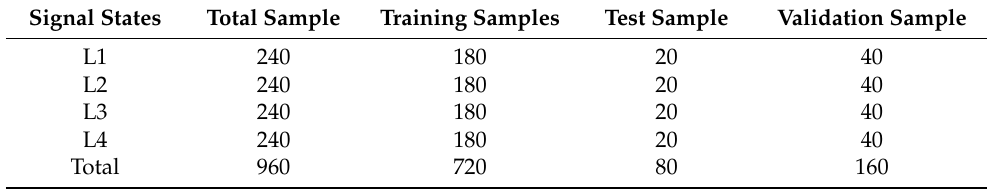
Table 4. The four preset fault time-frequency graph datasets of the VMD decompositions.